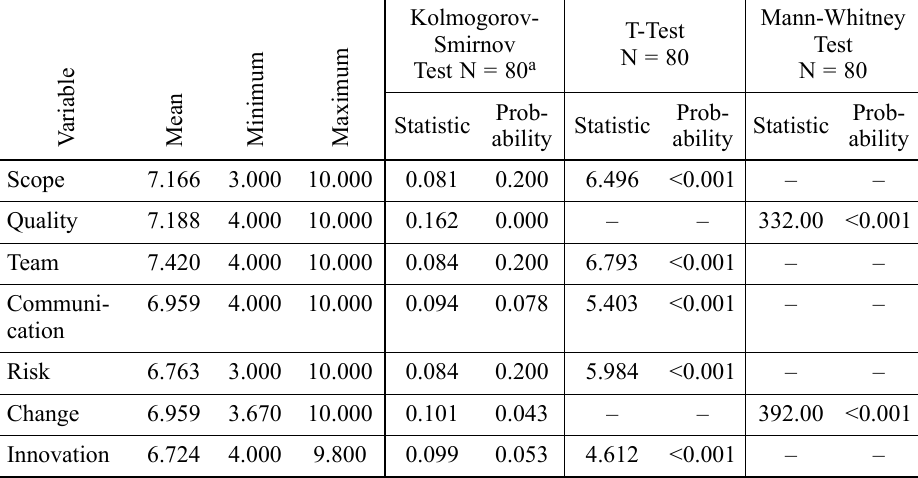
Table 2. Descriptive statistics, Kolmogorov-Smirnov tests,